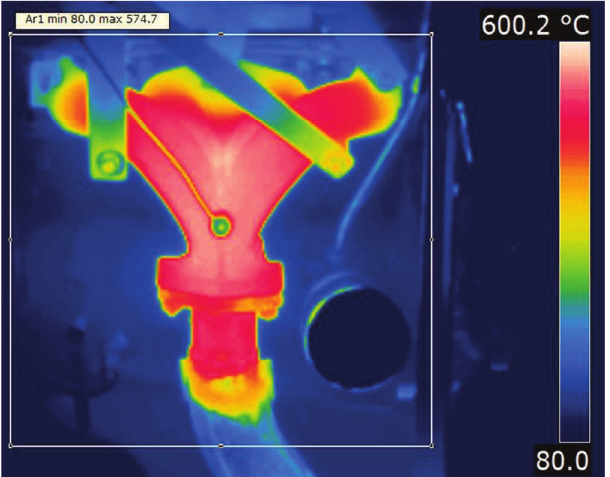
Fig. 10. Thermo-graphic image of the engine exhaust manifold (emissivity ε =